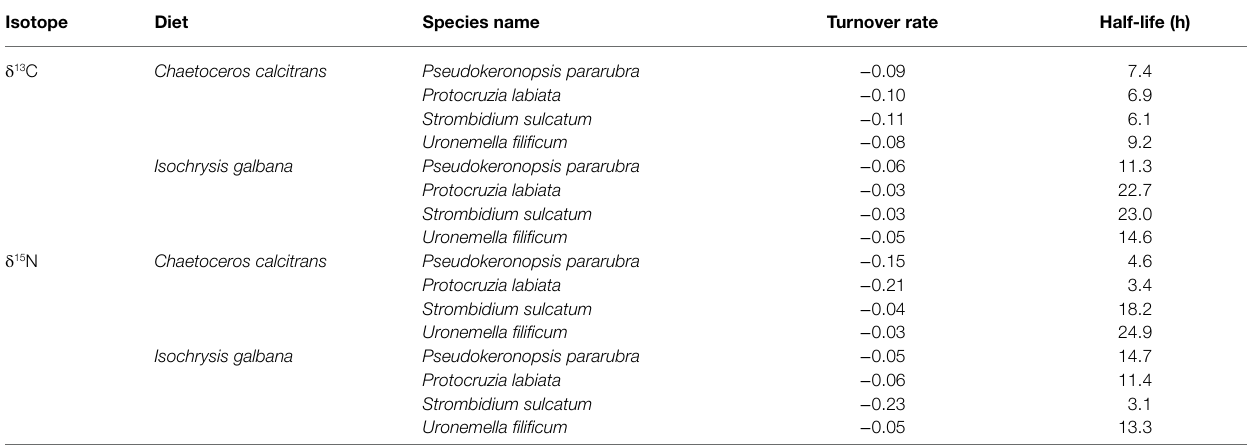
TABLE 3 | Turnover rate and half-life (h) of carbon and nitrogen elements in marine ciliates ( Pseudokeronopsis pararubra , Protocruzia labiata , Strombidium sulcatum , and Uronemella filificum ) fed with Chaetoceros calcitrans and Isochrysis galbana calculated using the exponential equation (y = a + be ct ) and regressions of carbon and nitrogen stable isotope data vs. time since diet